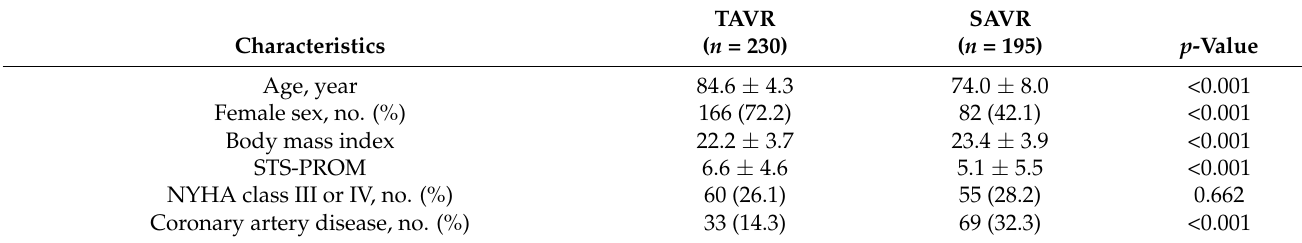
Table 1. Preoperative characteristics of the